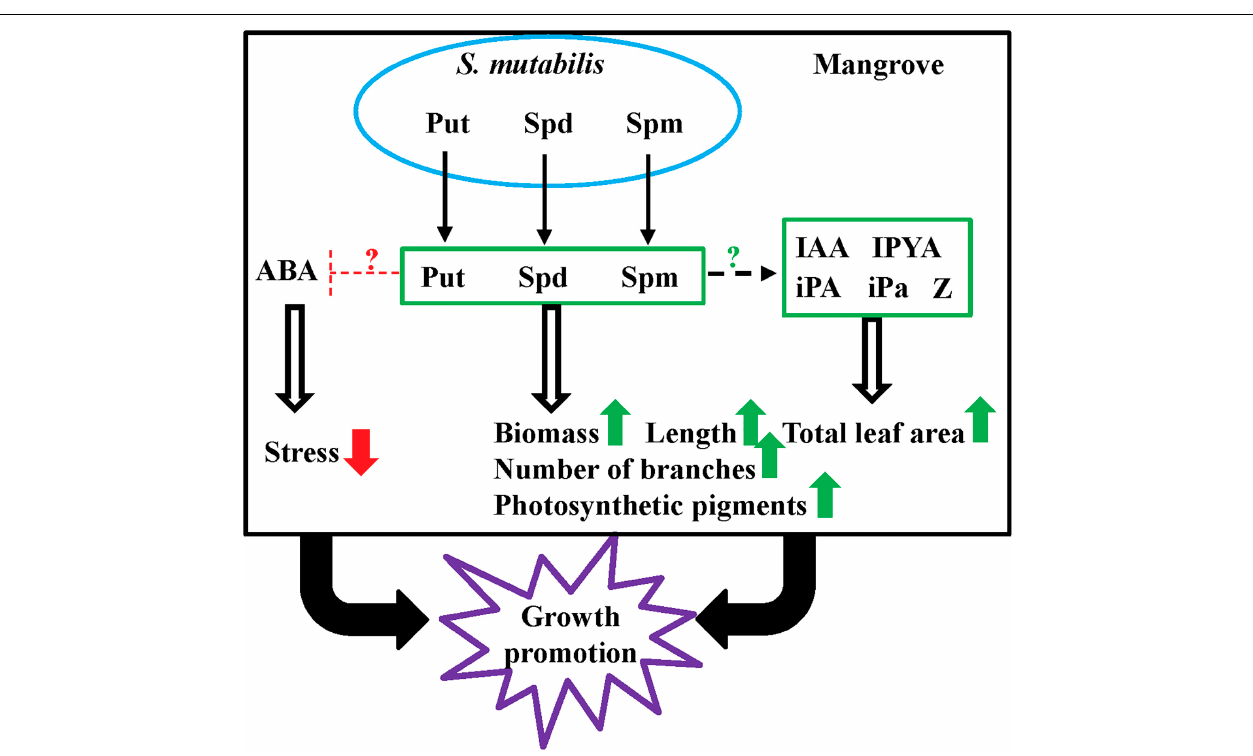
FIGURE 9 | Model of the endophytic Streptomyces mutabilis UAE1 promoting growth of mangrove. The increased PA (Put, Spd, and Spm) levels produced by the endophytic S. mutabilis UAE1 induce endogenous contents of Put, Spd, and Spm in tissues of mangrove, resulting in increasing other PGRs in plant tissues. In planta ABA was reduced, resulting in stress relief in plant tissues. This ultimately leads to increase biomass and length of roots and stems, number of branches of stems, and photosynthetic pigments in leaves. Taken together, the PA-producing isolate S. mutabilis UAE1 has the ability to promote growth of mangrove seedlings. Green and red arrows represent increase/stimulation and decrease/inhibition, respectively. ?, unknown induction/suppression mechanism. PA, polyamine; Put, putrescine; Spd, spermidine, Spm, spermine; IAA, indole-3-acetic acid; IPYA, indole-3-pyruvic acid; iPA, isopentenyl adenine; iPa, isopentenyl adenoside; Z, zeatin; GA 3 , gibberellic acid; ABA, abscisic